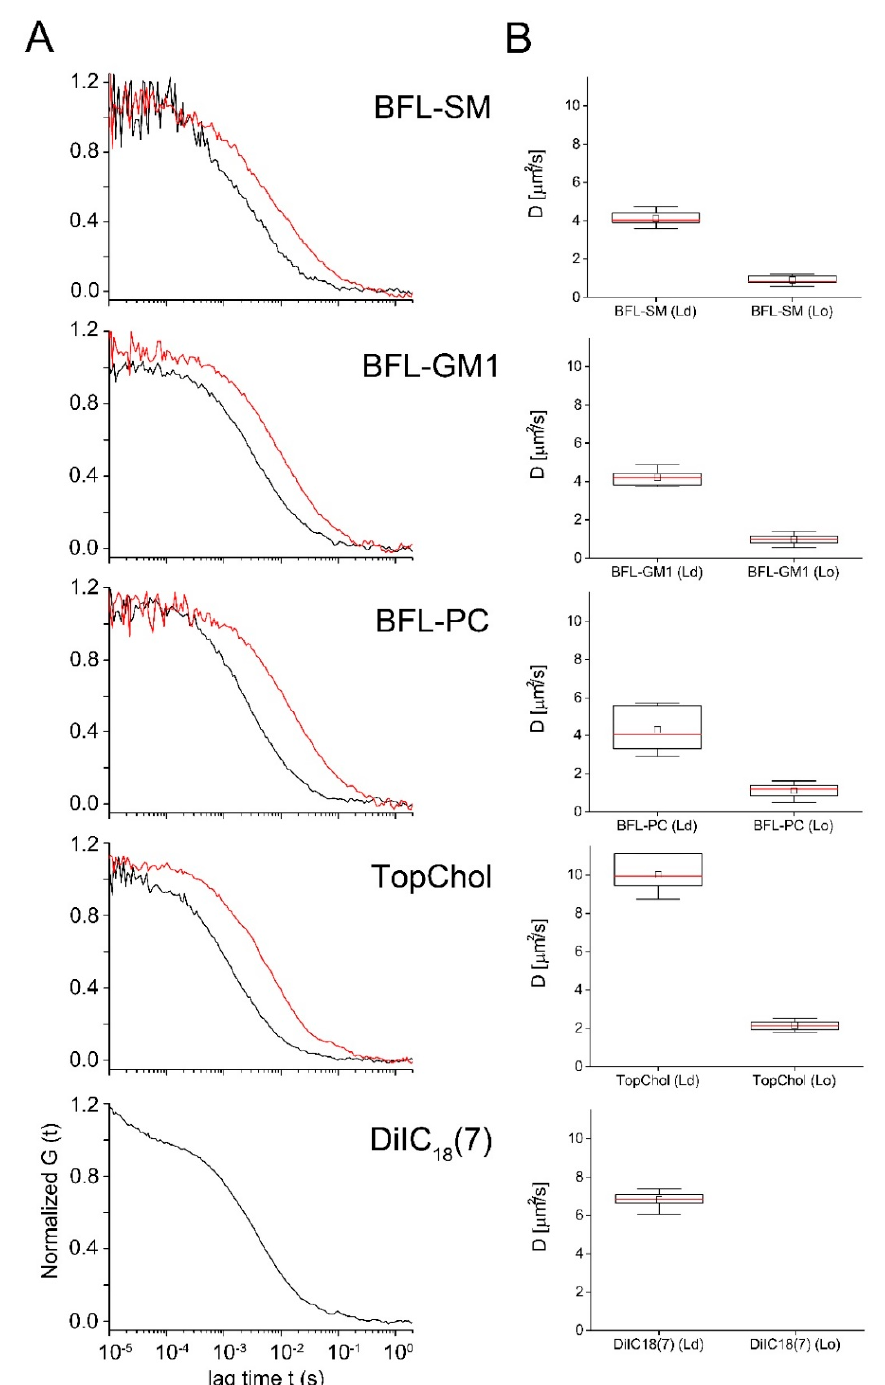
Figure 5. FCS measurements in liquid ordered (L o ) and liquid disordered (L d ) domains. The indicated fluorescent lipid tracers were incorporated into GUVs that underwent L o / L d phase separation (cf. Figure 4). ( A ) Normalized autocorrelation curves of representative measurements in L d -phases (black) and L o -phases (red). ( B ) Box plots of the resulting diffusion constants. Central small square average, red line median, large box limited by 75% and 25% quartiles, and whiskers extreme values of data. DiIC18(7) was completely excluded from the Lo phase. Fit results, statistics, and significance levels can be found in Table 2.